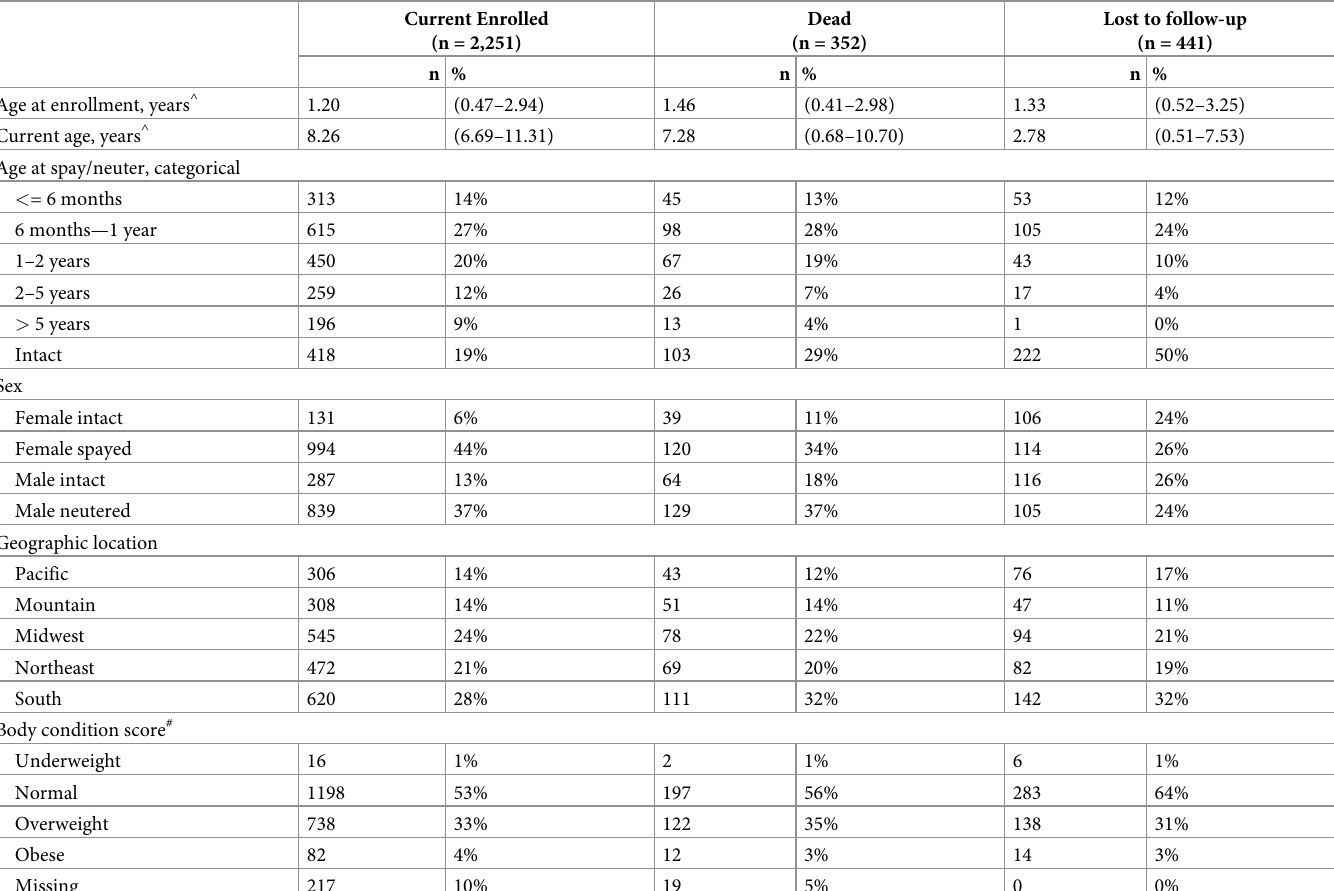
Table 2. Demographic information of study participants as of May 31,